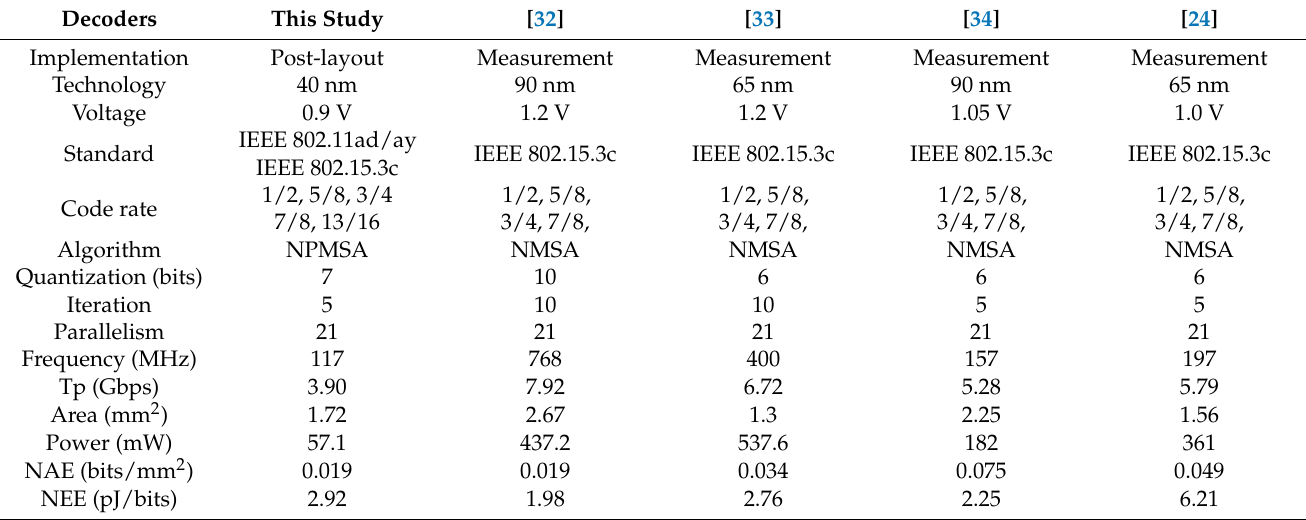
Table 5. Chip comparisons among different LDPC decoders for IEEE 802.15.3c